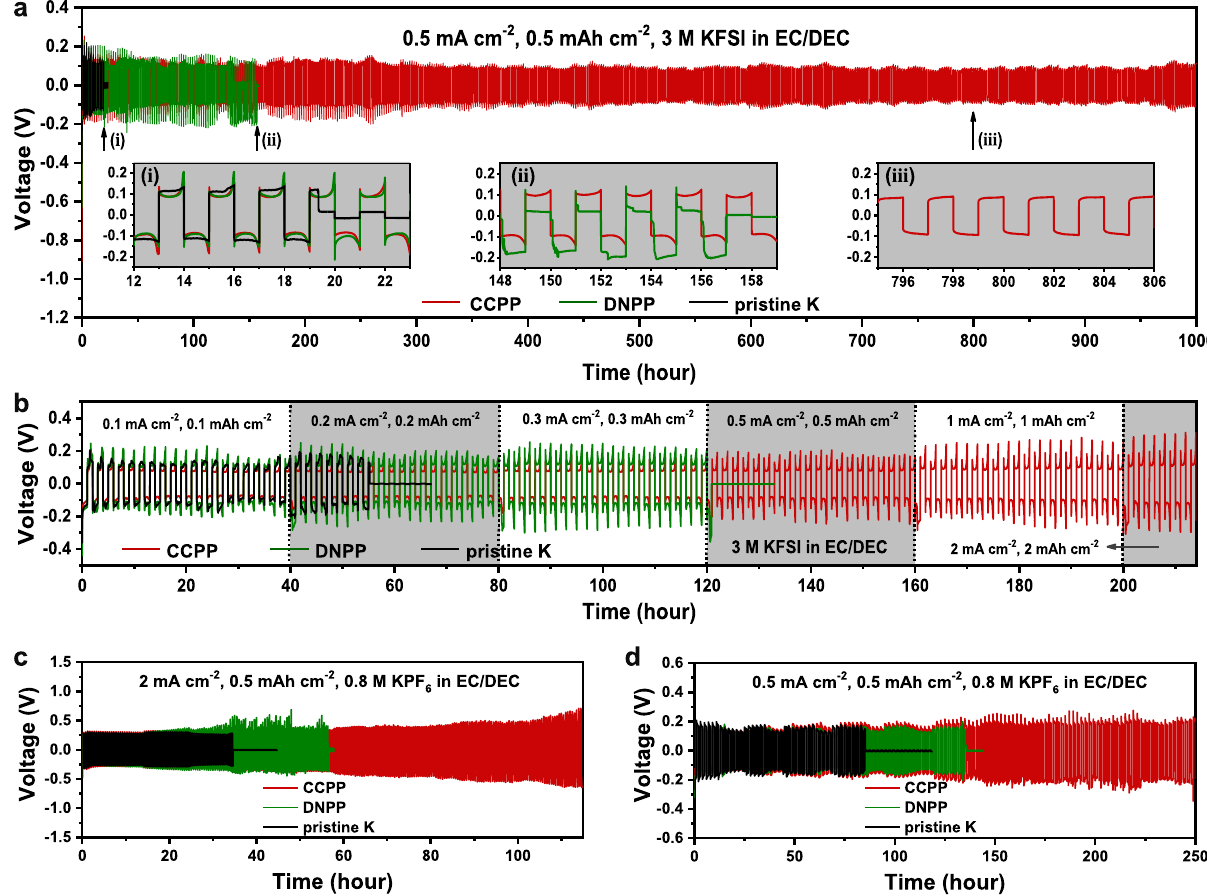
Fig. 4 Electrochemical properties of CCPP. a Voltage – time pro fi les of CCPP, DNPP and pristine K at the current density of 0.5 mA cm − 2 and capacity of 0.5 mAh cm − 2 in the highly concentrated KFSI/EC:DEC electrolyte, the illustrations (i), (ii), and (iii) are the detailed comparison of these three at 12 – 23 h, 148 – 159 h, and 795-806 h, respectively. b Rate performances of the three symmetric cells at different current and capacity conditions in the highly concentrated KFSI/EC:DEC electrolyte. c Polarizations of CCPP, DNPP and pristine K at 2 mA cm − 2 and 0.5 mAh cm − 2 by using KPF 6 /EC:DEC electrolyte. d Polarizations of CCPP, DNPP and pristine K at 0.5 mA cm − 2 and 0.5 mAh cm − 2 by using KPF 6 /EC:DEC electrolyte. Source data are provided as a Source Data fi